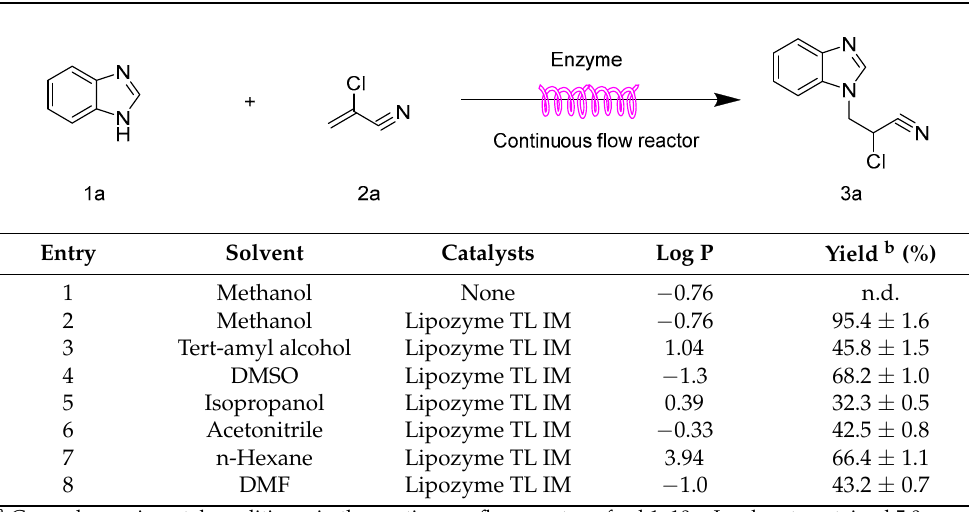
Table 1. The effect of solvent on the enzymatic synthesis of N-substituted benzimidazole derivatives in continuous-flow microreactors a .